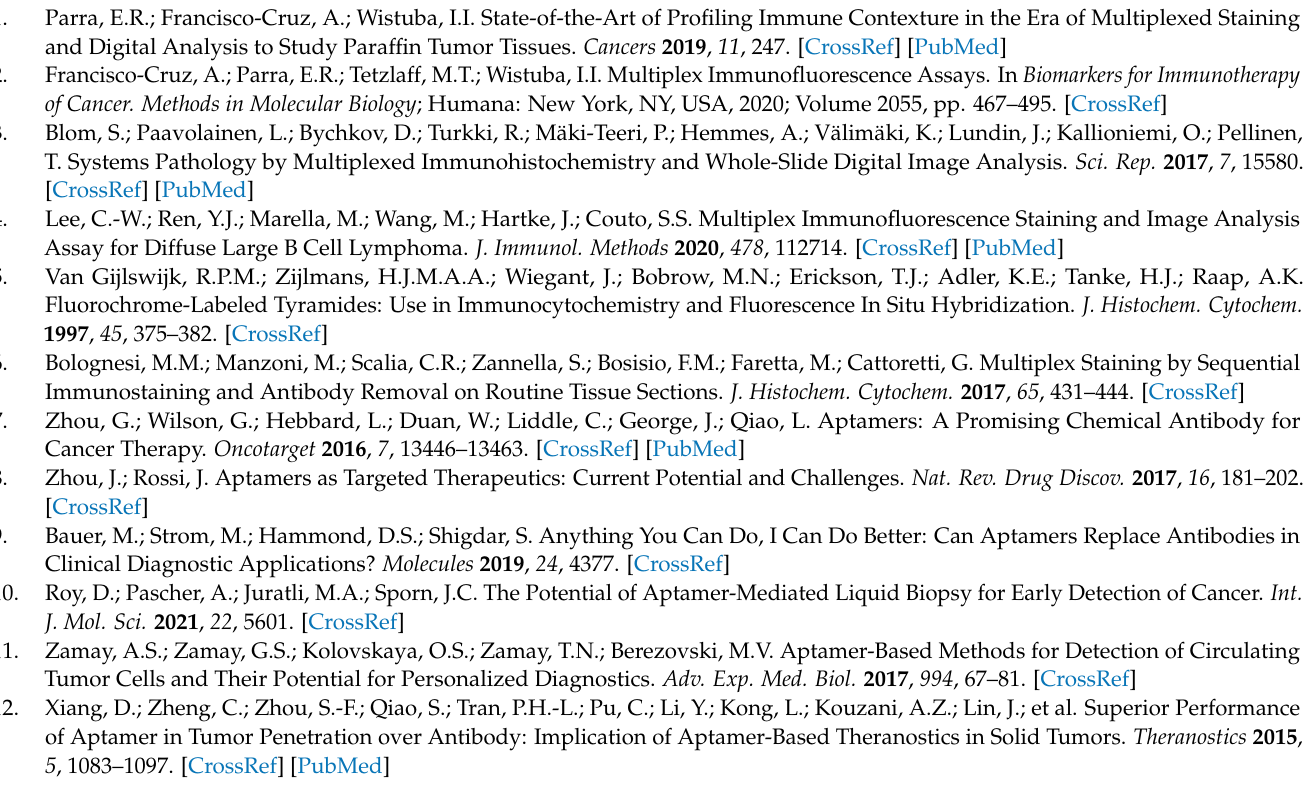
Figure S3: Surface plot showing the intensity profile of cells represented in Figure